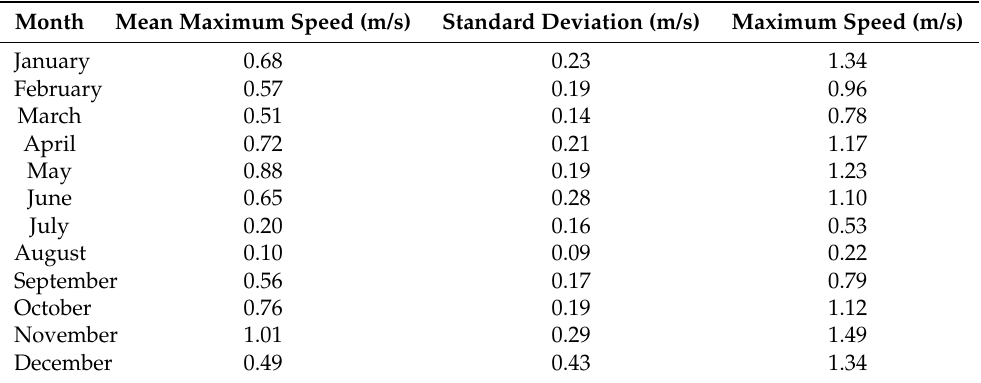
Table 2. Summary of the statistics for maximum event speed. Mean Maximum Speed is the monthly averaged speed of the leading wave obtained from the model at 100 m depth. The maximum speed is the largest event simulated at each month over the 10 years